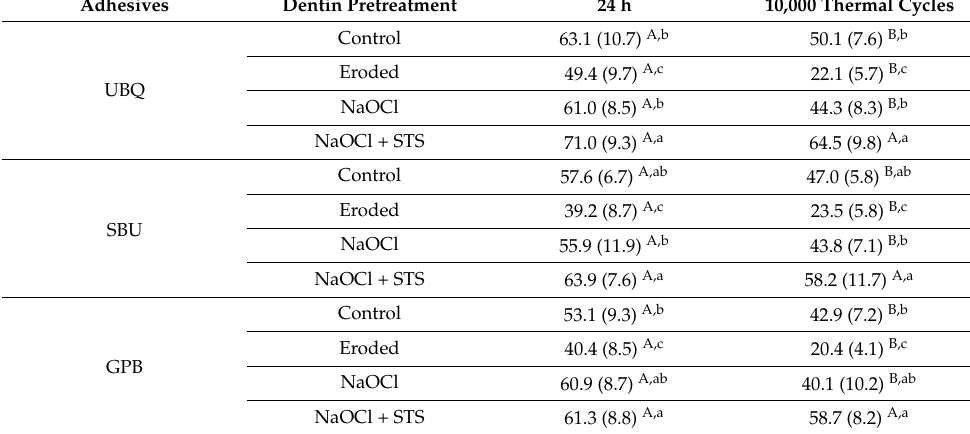
Table 3. µ TBS results: Mean (SD) in